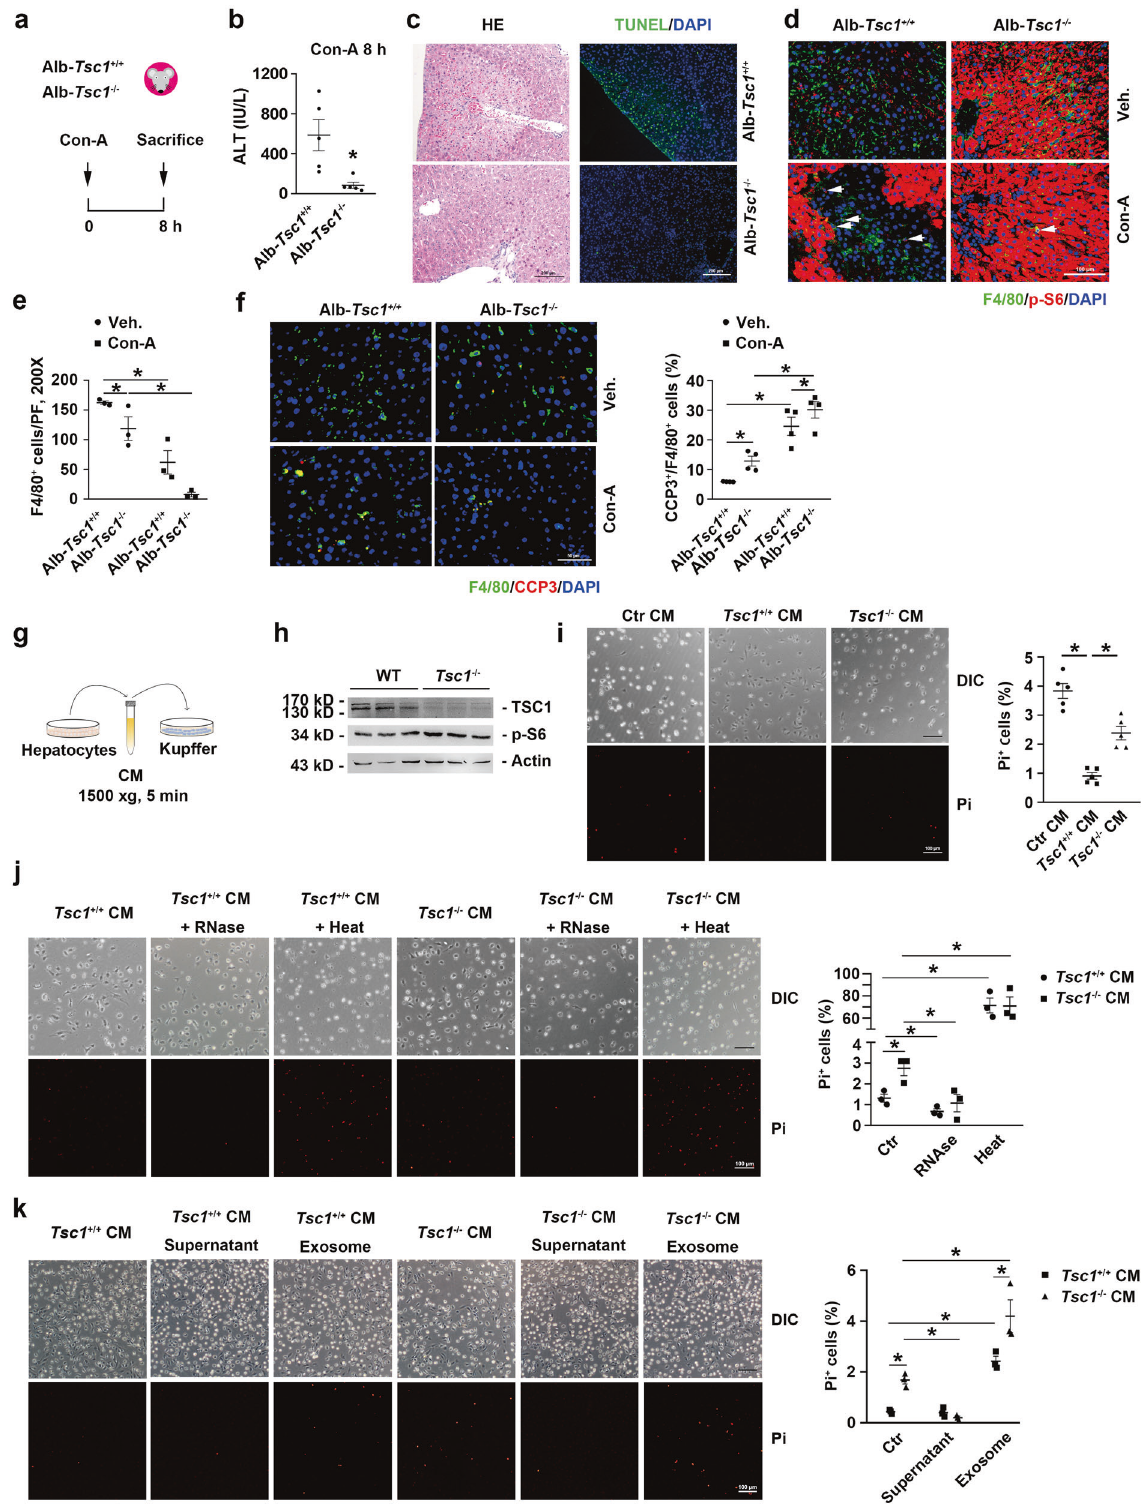
(M Φ - Tsc1 -/- mice, Fig. 4a and Supplementary Fig. 7)